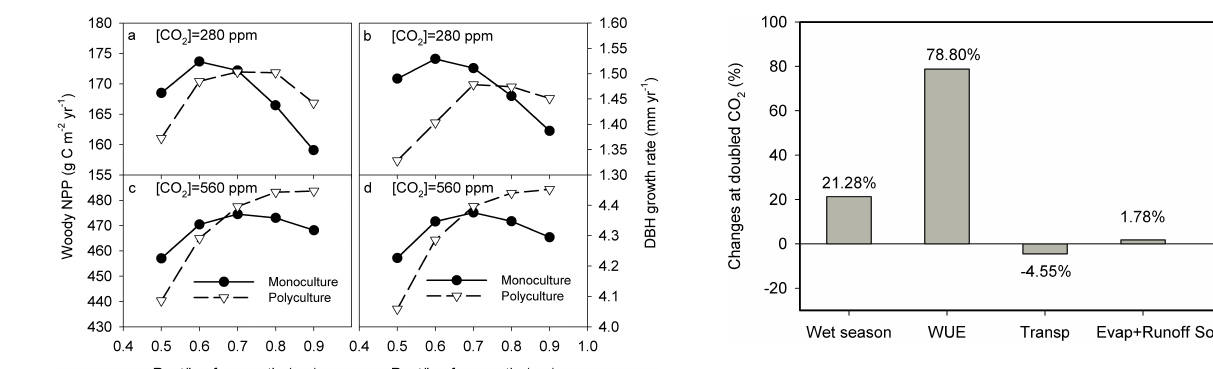
Figure 11. Changes in wet period length, water use efficiency (WUE), hydrological fluxes, and soil moisture due to a doubling of atmospheric CO 2 concentration. The bars show the percentage dif- ferences between LM3-PPA run with a single PFT ( ϕ RL = 0.7) at [CO 2 ] = 560ppm and at preindustrial [CO 2 ] (280ppm). The “Wet season” bar shows the effect of a doubling of preindustrial [CO 2 ] on the fraction of each growing season in which canopy trees in the monoculture simulation are water-saturated (defined as the frac- tion of days during the growing season in which water supply was greater than or equal to demand at 14:00 over the final 60 years of a 500-year run). The “WUE” bar shows the change in the water use efficiency of canopy trees during the water-limited period (days in which water supply was less than demand at 14:00). The “Transp” and “Evap + Runoff” bars show the changes in water transpired by plants and lost via evaporation and runoff over the last 60 years of the model runs; when expressed in absolute amounts (mmyr − 1 ) , the decrease in transpiration and the increase in evaporation plus runoff almost exactly cancel each other out (see Sect. 3.3 in the Results). The “Soil moisture” bar shows change in growing-season mean soil moisture at doubled [CO 2